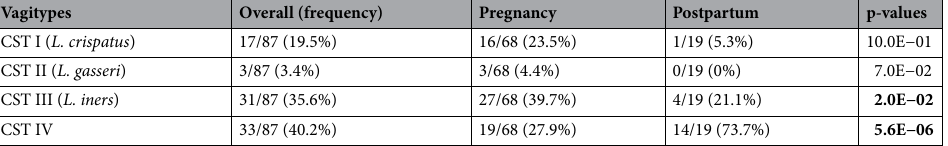
Vagitypes Overall (frequency) Pregnancy